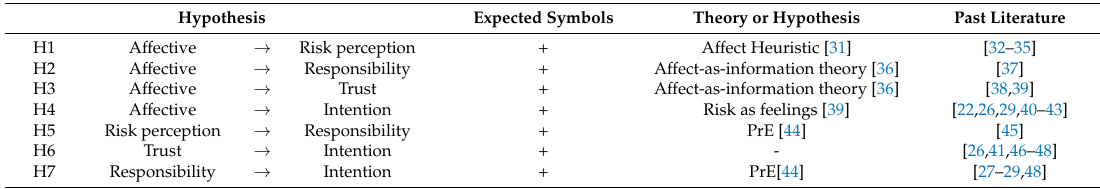
Table 1. The set of pathways, expected symbols, theories, and